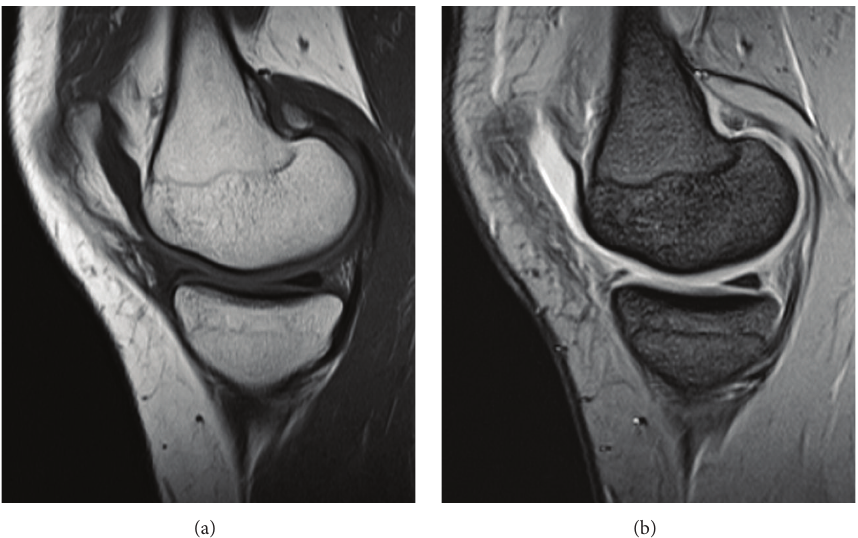
Figure 3: No abnormal signals adjacent to the anterior horn of the medial meniscus were noted on magnetic resonance images at 12 months